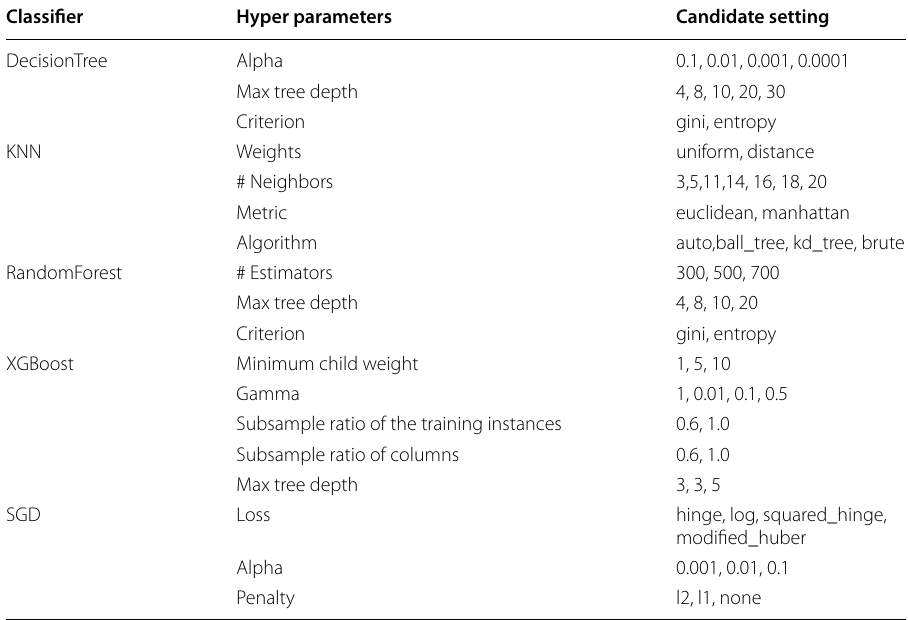
Table 6 The grids used for the tuning of